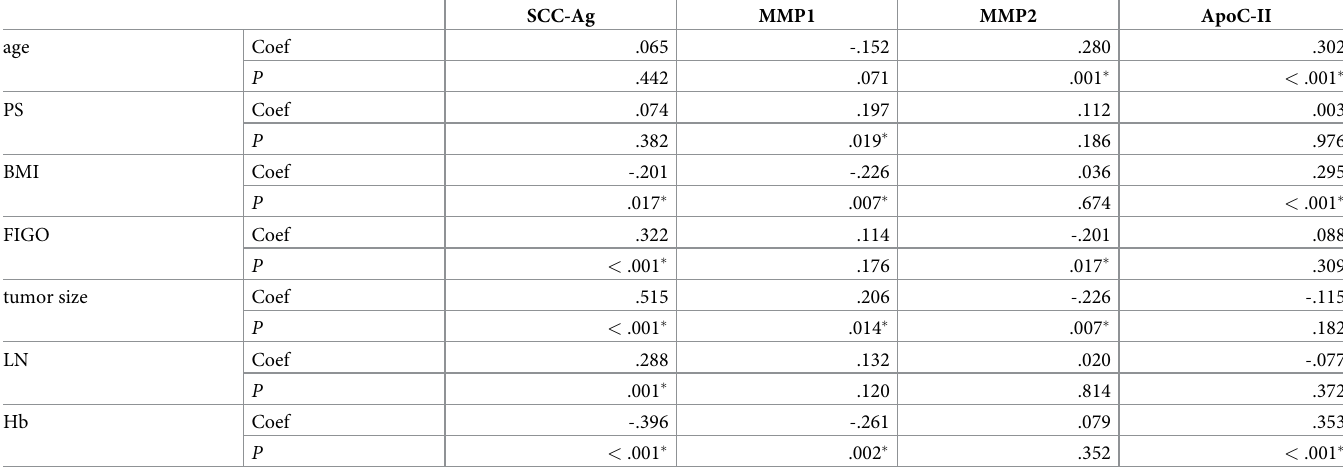
Table 5. The correlation between pretreatment serum biomarkers and clinical variables. respectively [42]. Olsen et al. reported that CC patients who could not achieve normalized and showed a decreased PFS [43]. Although the cut-off points varied, that is, 0.9 ng/ml, 1.15 ng/ml, and 2.2 ng/ml (2.0 ng/ml in our study), the survival rates of patients with elevated post-